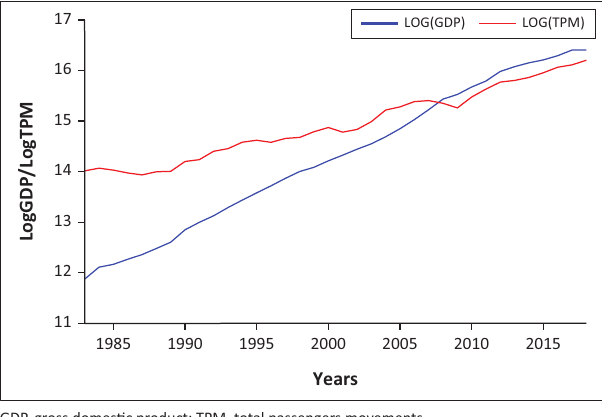
FIGURE 1: Real gross domestic product and the number of passengers traveling by air to, from and within Sri Lanka from 1983 to 2019.